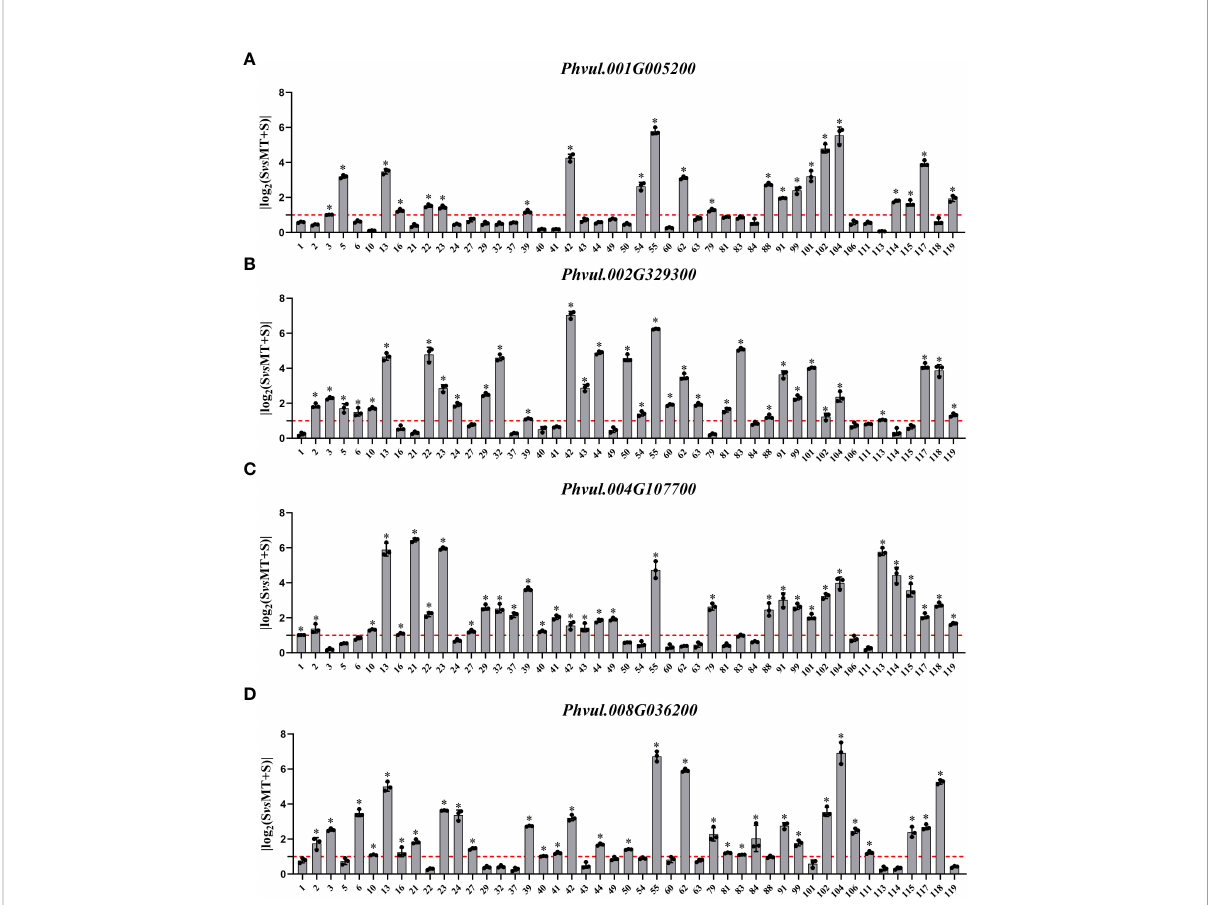
FIGURE 6 Effects of exogenous melatonin on the expression of genes associated with the “ Plant-pathogen interaction (pvu04626) ” pathway-related KEGG terms in common bean germplasm resources under salt stress. The horizontal axis represents the number of resources, while the vertical axis shows the log 2 (fold change) values. Log 2 (fold change) value 1 (red line) is the critical value showing changes in the expression, while the columns higher than the red line represent the expression level with a signi fi cant change ( P<0.05 ). * represents genes with signi fi cant different expression levels between S (salt) and M+S (melatonin and salt) treatments. (A) Expression analysis of Phvul.001G005200 . (B) Expression analysis of Phvul.002G329300 . (C) Expression analysis of Phvul.004G107700 . (D) Expression analysis of Phvul.008G036200 .